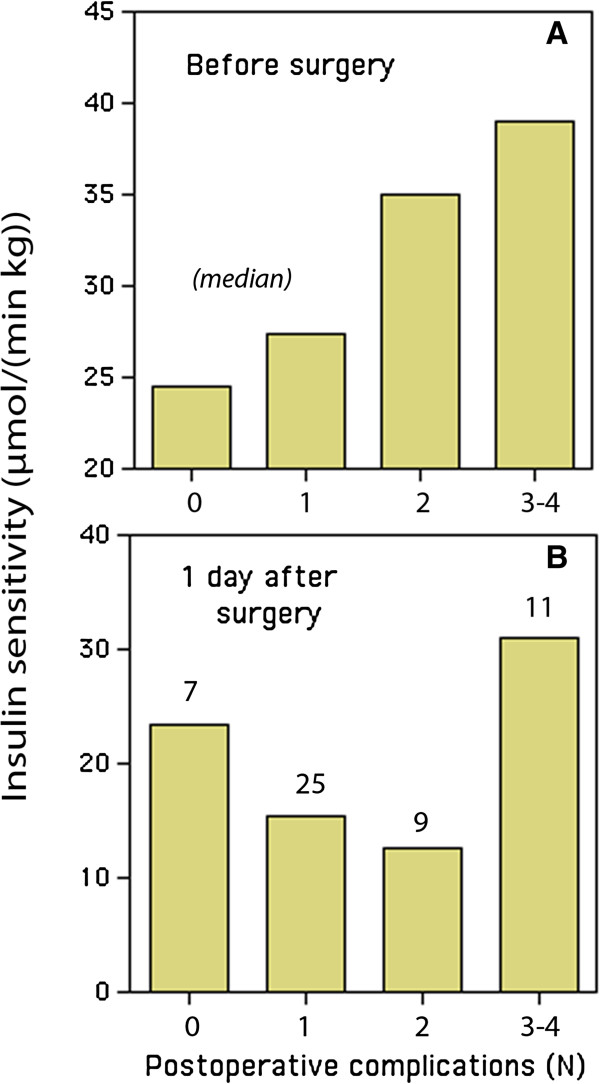
Insulin sensitivity before (A) and after (B) elective hip replacement surgery. Low insulin sensitivity = insulin resistance. A research nurse recorded the number of complications 2 days postoperatively. The numbers shown on top of the bars in B denote the number of patients.